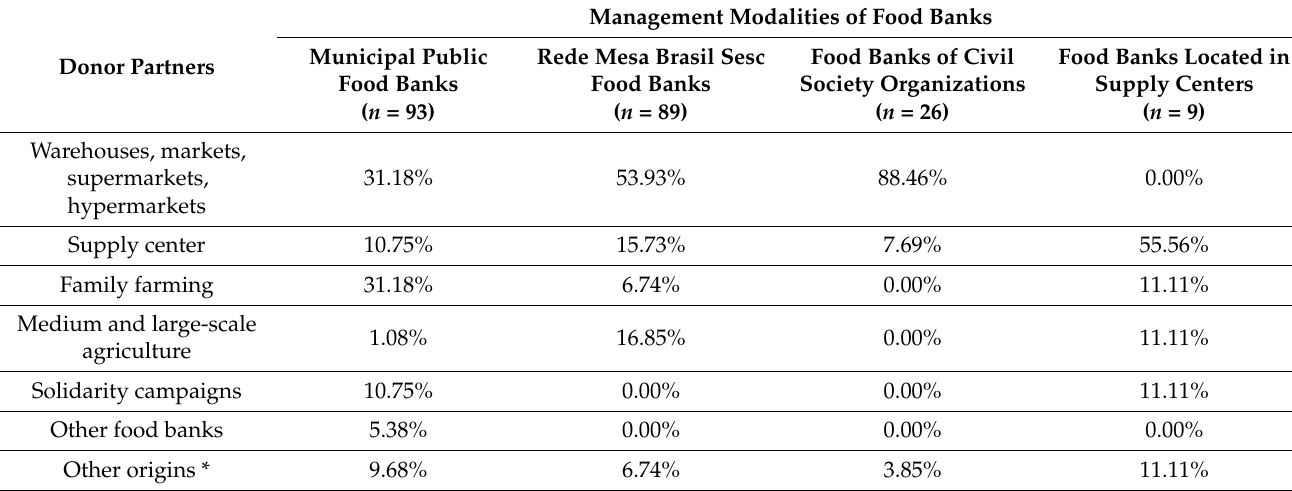
Table 2. Distribution of Brazilian food banks, according to donor partners and management modality, in 2019 ( n = 217). Management Modalities of Food Donor Partners